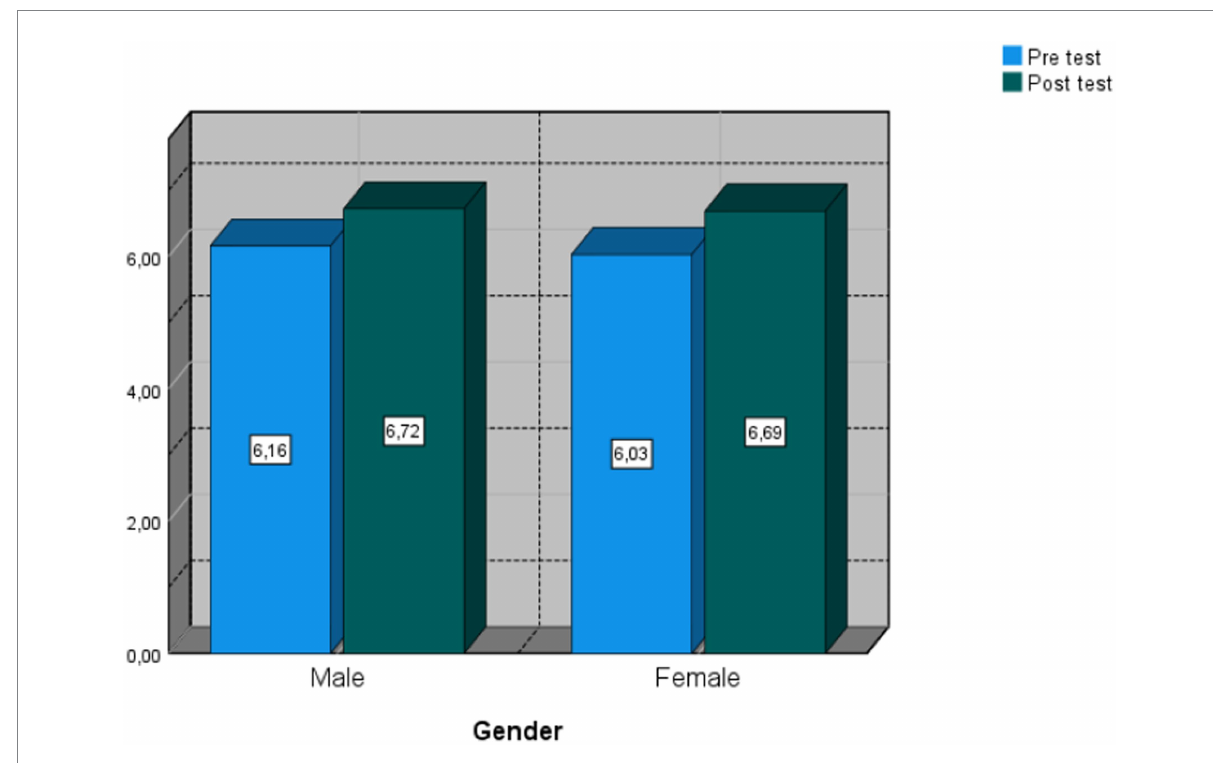
FIGURE 6 Scores in solving mathematical problems found in the pre- and post-test